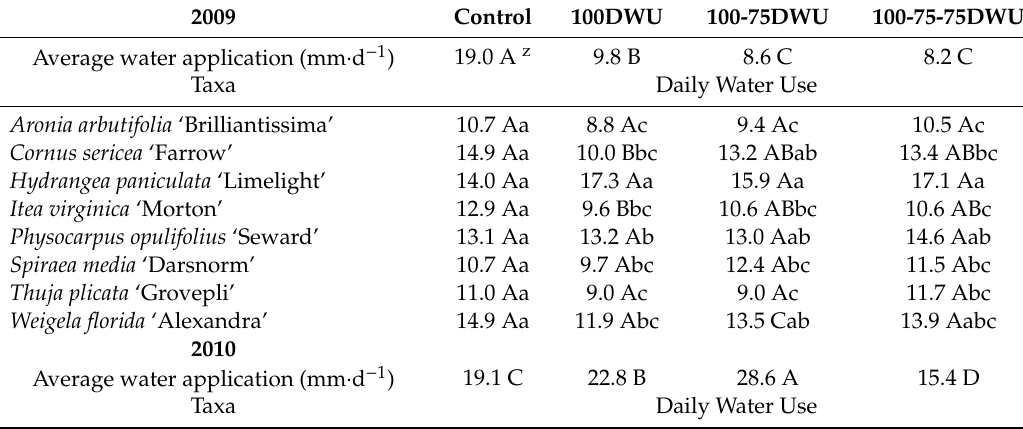
Table 2. Season average daily irrigation application (mm . container − 1 ) and average daily water use (mm . container − 1 ) of eight shrubs grown in 10.2 L containers under four irrigation treatments administered 11 June (Day 1) to 14 October 2009 (Day 126) and 23 June (Day 1) to 31 October 2010 (Day 131). Control = 19 mm . application − 1 (1.02 L . day − 1 ); 100DWU = 100% daily water use (DWU) replacement each day; 100-75DWU = 2-day cycle alternating 100% DWU and 75% DWU; and 100-75- 75DWU = 3-day cycle with 100% DWU replacement the first day then 2 days 75% DWU replacement.